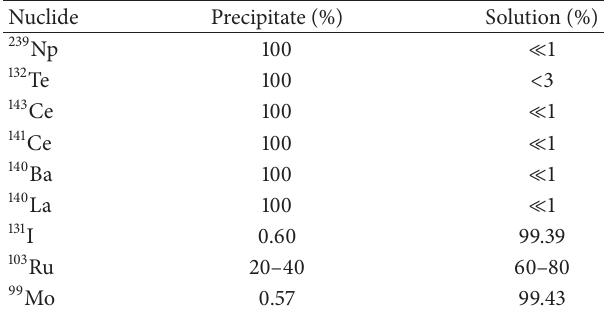
Table 6: Quality parameters of fission 99 Mo produced at PIN- STECH meeting international